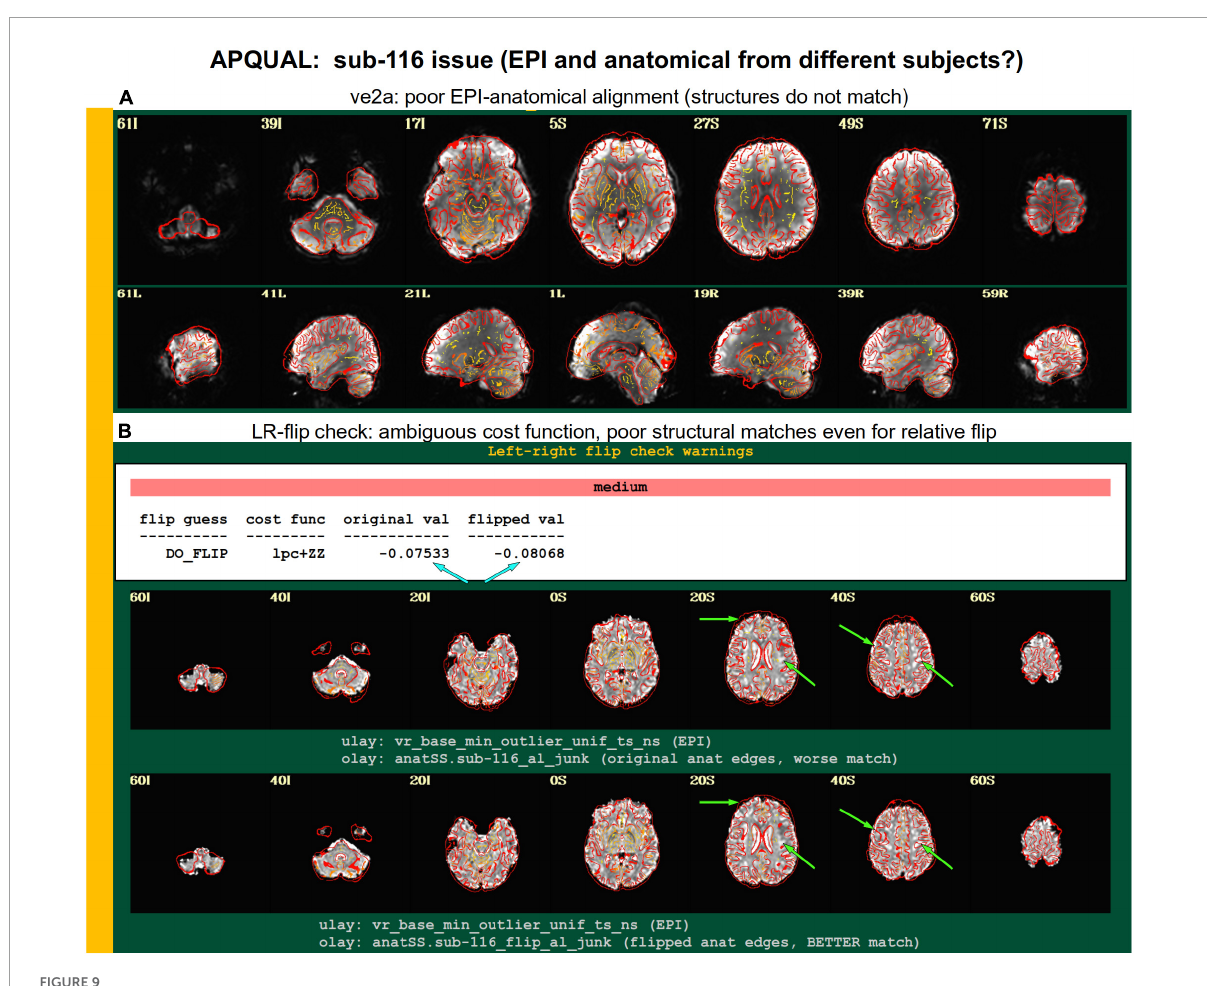
FIGURE9 Combining APQUAL blocks: ve2a and warns (see Figures 3 , 8 ). The structures of the aligned EPI do not match well with those of the anatomical, even though neither appears heavily distorted [ve2a, (A) ]. The left-right flip check provides a “medium” level warning, because the cost function comparison is ambiguous [warns, (B) ; see blue arrows]. Visually, neither the original nor flipped EPI matches well with the anatomical structures, even though all other subjects in the group had strong alignment. Since the structures appear to differ, this suggests that the EPI and anatomical volumes for this dataset may actually come from different